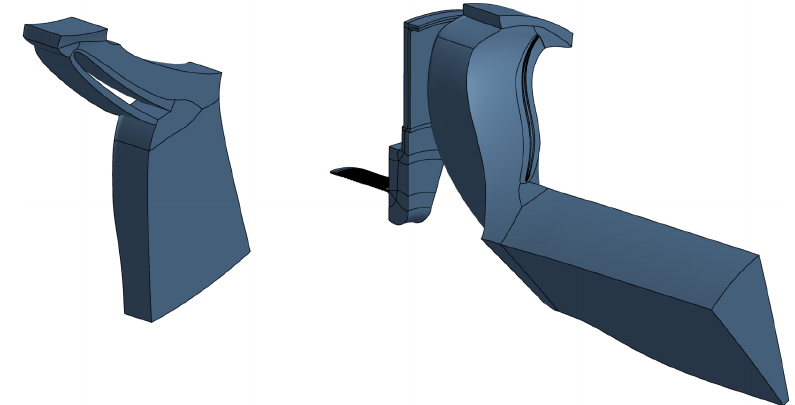
Figure 1. Computational domain.